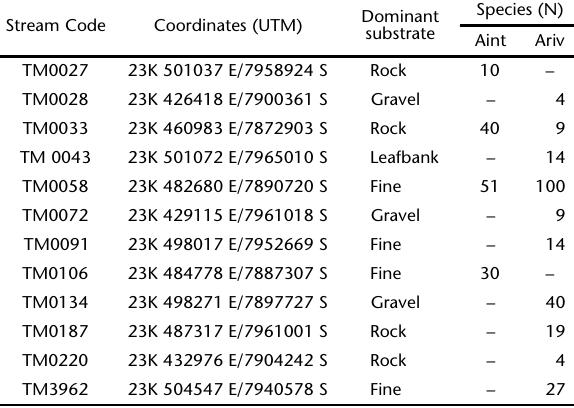
Table I. Location, dominant substrate, and number of individuals of Astyanax intermedius (Aint) and Astyanax rivularis (Ariv) of each sampled stream.